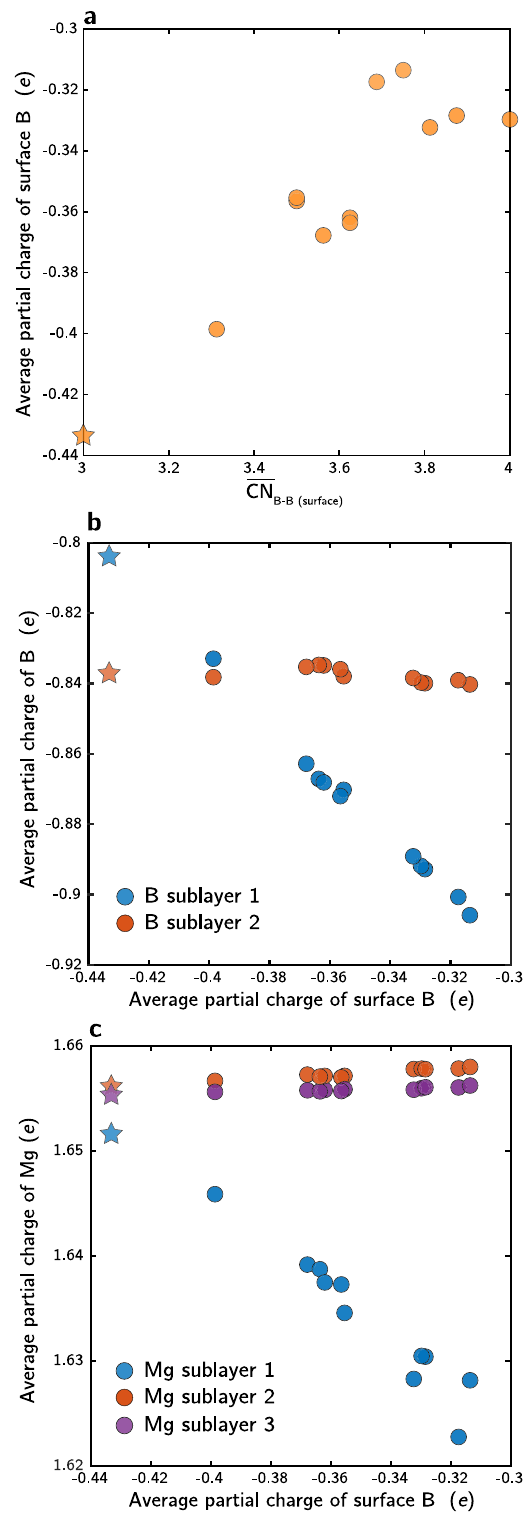
Fig. 3 Partial charge analysis. a Average partial charge of surface B atoms as a function of surface B − B coordination number. Average partial charge of b other B layers and c Mg layers as a function of the average partial charge of surface B atoms. B and Mg layer indices are de fi ned according to their proximity relative to the outermost boron surface. Data are compiled from all computed 4 × 4 surface con fi gurations in Fig. 1. Stars represent the pristine hexagonal